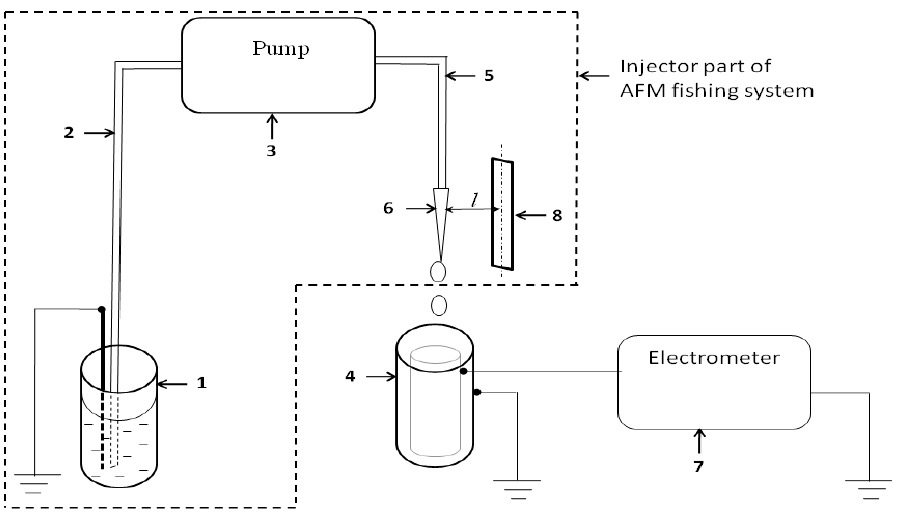
Figure 1. Experiment setup. ( 1 ) Measuring cell with analyzed liquid; ( 2 ) Silicone pipe (incoming section); ( 3 ) Peristaltic pump; ( 4 ) Measuring cell coupled with electrometer ( 7 ); ( 5 ) Silicone tube